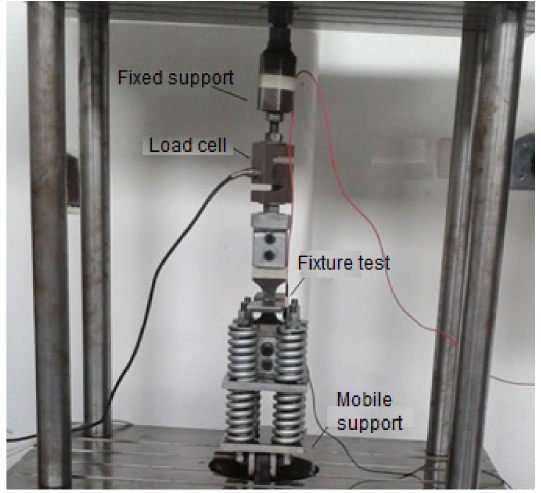
Figure 3. Assembly for the axial fatigue